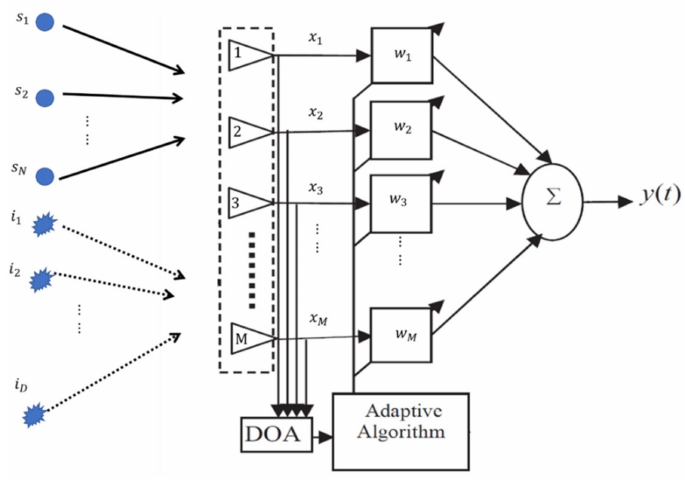
Figure 1. M antenna elements with N desired signal and D interference